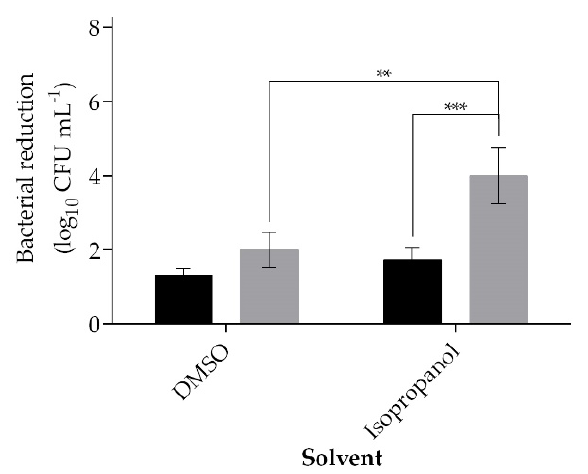
Figure 2. S. aureus reduction after exposing a bacterial suspension for 5 min to 0.02-mM CTAB (black) alone or in combination with 1 mM of cinnamaldehyde (grey) when two different solvents were used on the formulation (dimethyl sulfoxide (DMSO) or isopropanol). Values are mean ± SD. The statistical significance is represented (** p < 0.01 and *** p < 0.001).